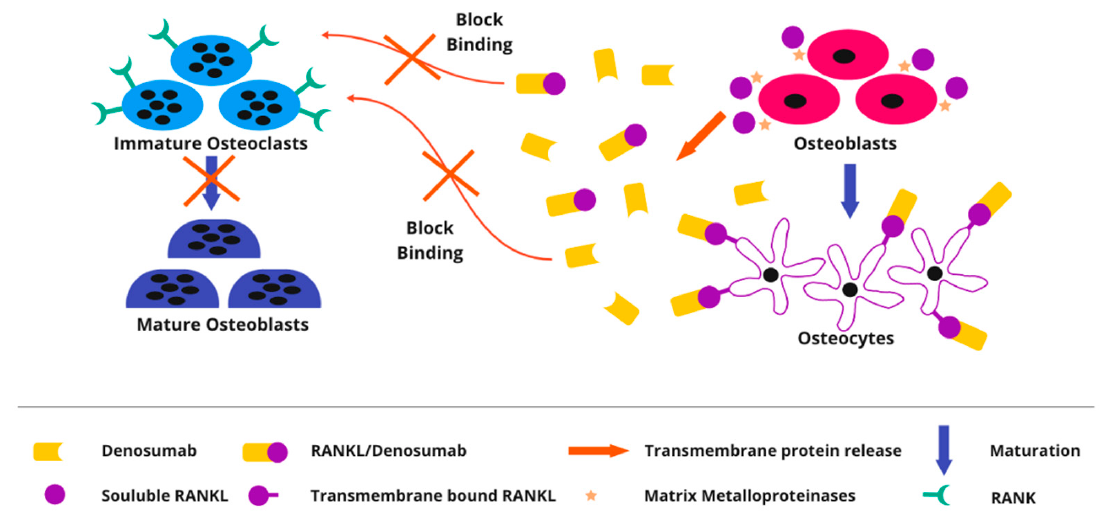
Figure 7. Mechanism of action of a Denosumab, targeting RANKL. RANKL has been demonstrated to exist in a variety of forms. The most physiologically active is the transmembrane version of RANKL on osteocytes. It promotes osteoclast activity upregulation. Metalloproteinases have been demonstrated to release soluble forms of RANKL from the membrane. Denosumab suppresses osteoclastogenesis by binding to RANKL and as a result inhibiting RANKL and preventing RANKL binding to RANK. Denosumab only inhibits osteoclastogenesis, not osteoclast survival. RANKL— nuclear factor ‐ kB receptor activator ligand; RANK—receptor located on osteoclasts.